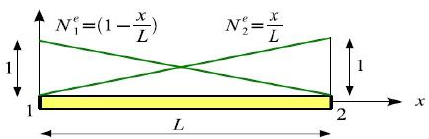
Figure 2. Interpolation functions on a 2-node bar element.